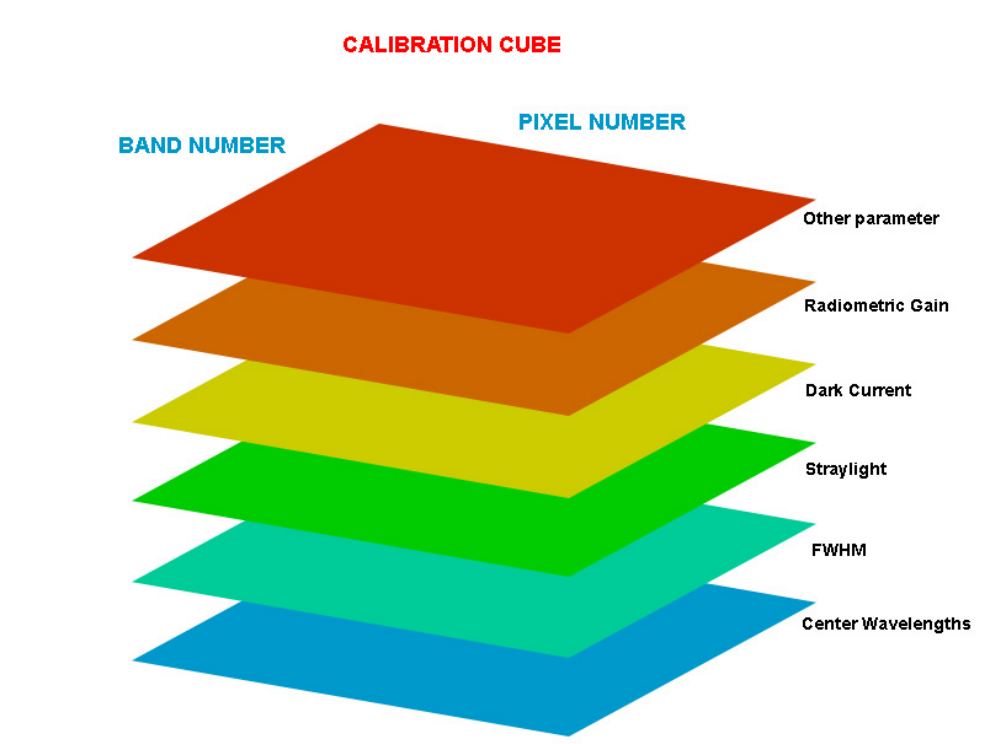
Figure 5. Visualization of a Calibration